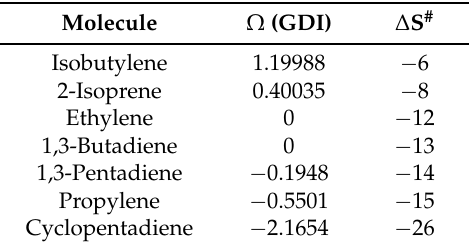
Table 7. Activation entropy and molecular interaction capacity for the dimerization of second order for unsaturated molecules in gaseous state. Molecule Ω (GDI) ∆ S #